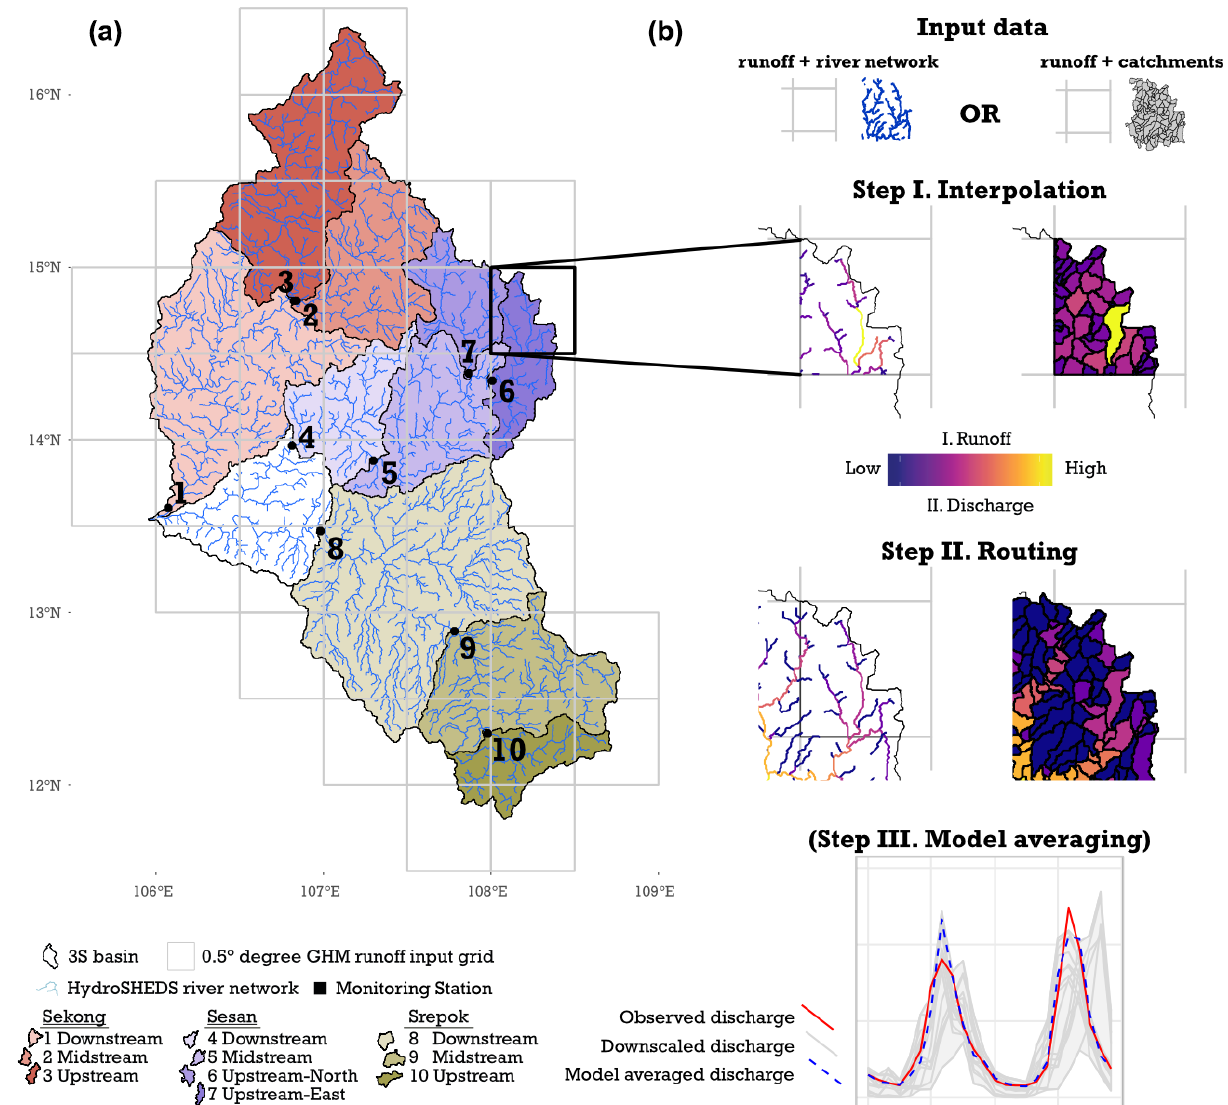
Figure 1. (a) Study area and the data used in the empirical study: runoff from global hydrological models at 0.5 ◦ resolution, a river network, and monitoring data. (b) The three steps in a typical Hydrostreamer workflow. Step I: areal interpolation, or area-to-line interpolation, to distribute runoff from source zone to target zones (or river lines). Step II: river routing. Step III: model averaging to create a multi-model combination (and regionalisation) if data from monitoring stations are